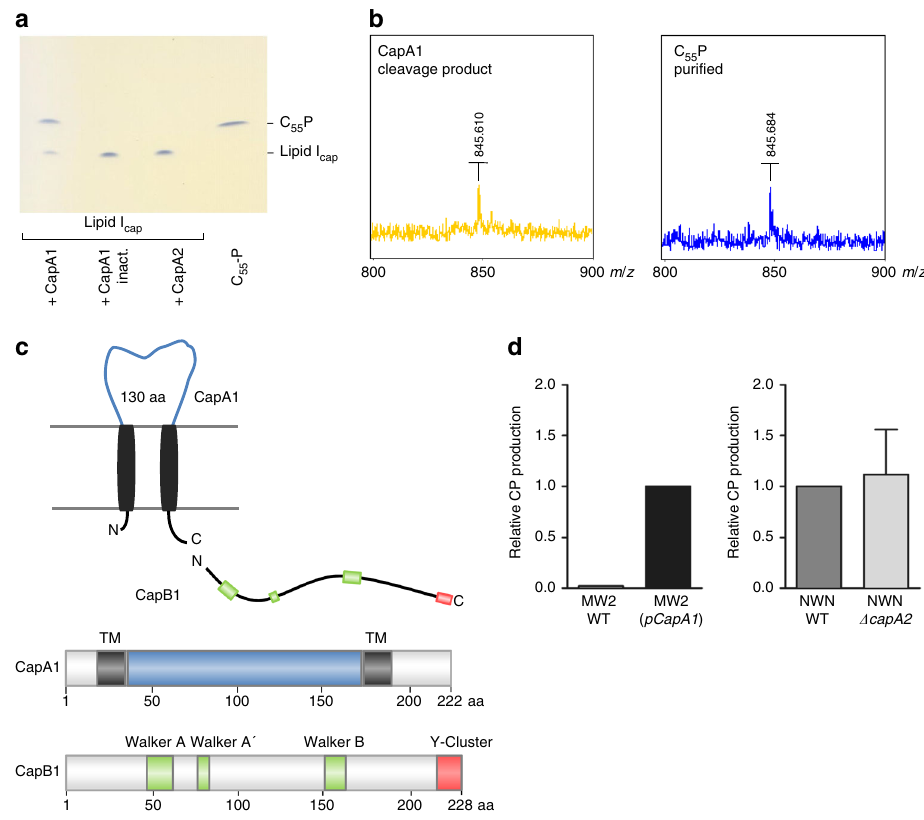
Fig. 4 CapA1 exhibits phosphodiesterase activity towards lipid-linked capsule precursors. a Puri fi ed lipid I cap (2 nmol) was incubated in the presence of either CapA1 or CapA2 (4 µ g each). After extraction with BuOH/PyrAc, reactions were analyzed by TLC and PMA staining. b MS analysis of the CapA1 cleavage product isolated via preparative TLC. MALDI-TOF MS spectra were obtained with a Bi fl ex III instrument running in negative mode. The m/z of 845.61 corresponds to the singly charged C 55 P molecule, which has a measured mass of 845.68 and a calculated neutral mass of 846.67. c CapA1 is anchored to the cytoplasmic membrane via two transmembrane helices fl anking an extracytoplasmic loop of 130 amino acids. The catalytic domains of CapB1 kinase contains the Walker A, A ′ and B motifs (green); a tyrosine-rich region containing the phosphorylation sites is present at the C-terminus (red). d ELISA-based quanti fi cation of CP production in S. aureus MW2 complemented in trans with pCapA1 (left) and S. aureus Newman wild type and a Δ capA2 deletion mutant (right). Experiments were performed in triplicate. The error bars represent the mean ± SEM from three biological